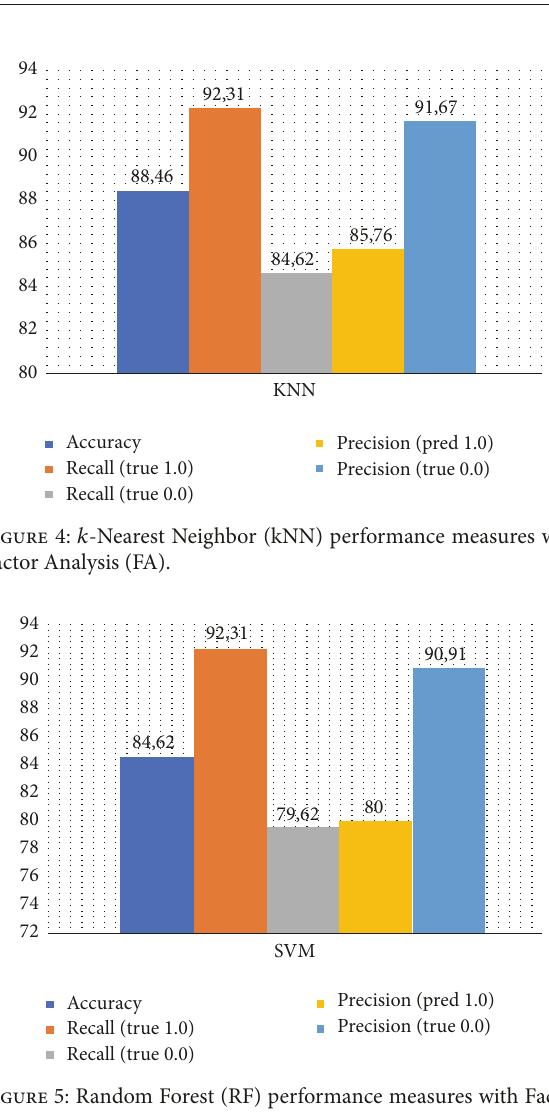
Figure 5: Random Forest (RF) performance measures with Factor Analysis